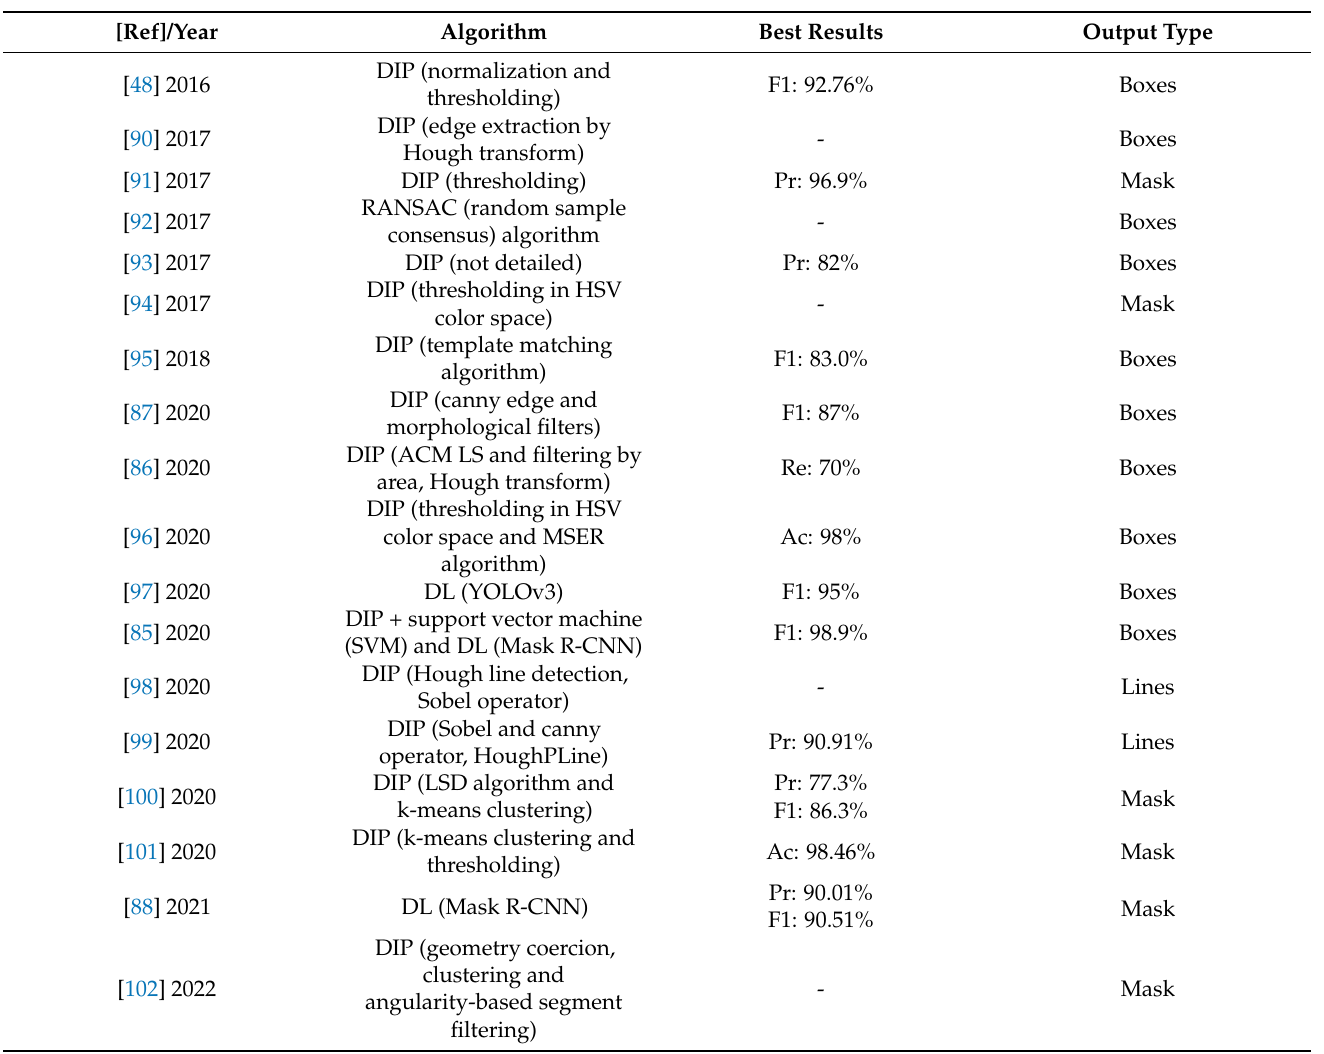
Table 3. Summary of methods for detecting PV modules in aIRT using DIP and DL